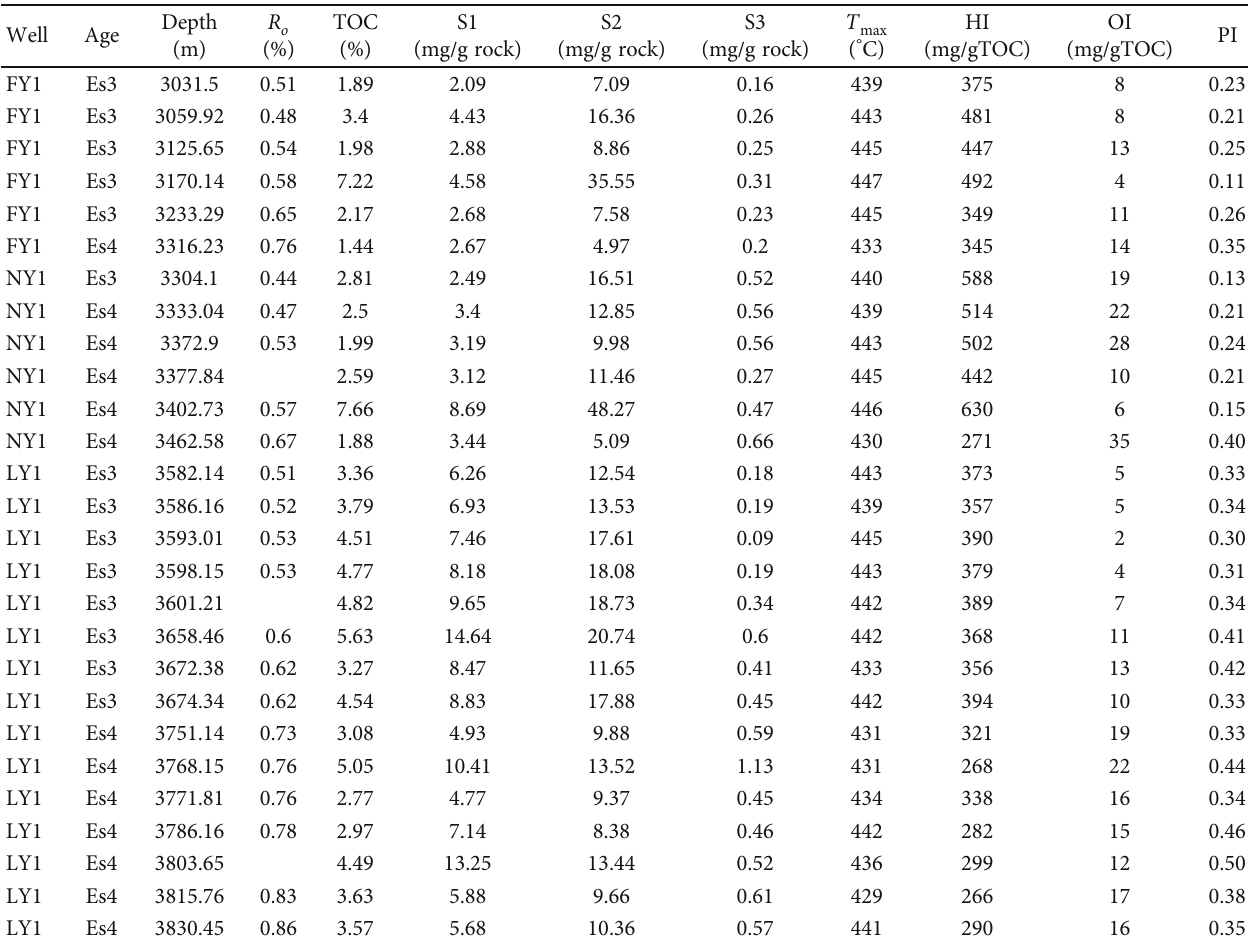
Table 1: Results of Rock-Eval analysis and vitrinite re fl ectance measurement of studied samples from the Dongying Depression.